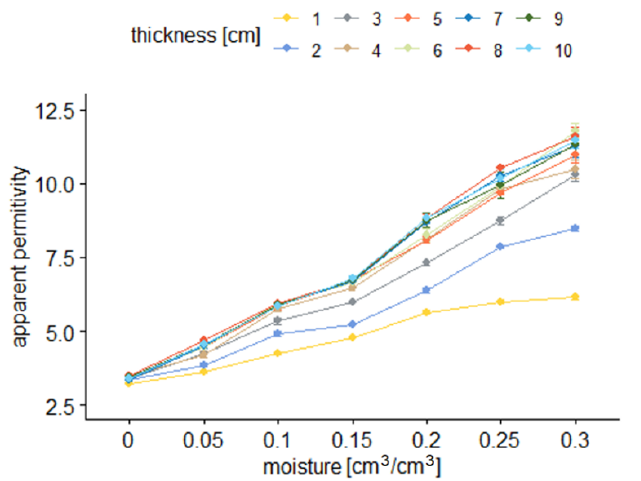
Figure 8. Average apparent permittivity readouts with sensor B depending on sample thickness for particular material moisture.